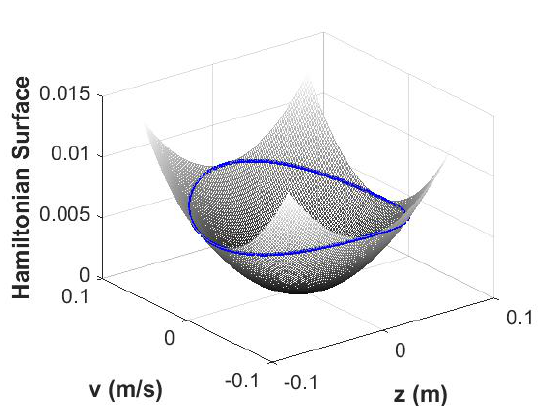
Figure 3. The Hamiltonian surface and WEC trajectory for Case Study